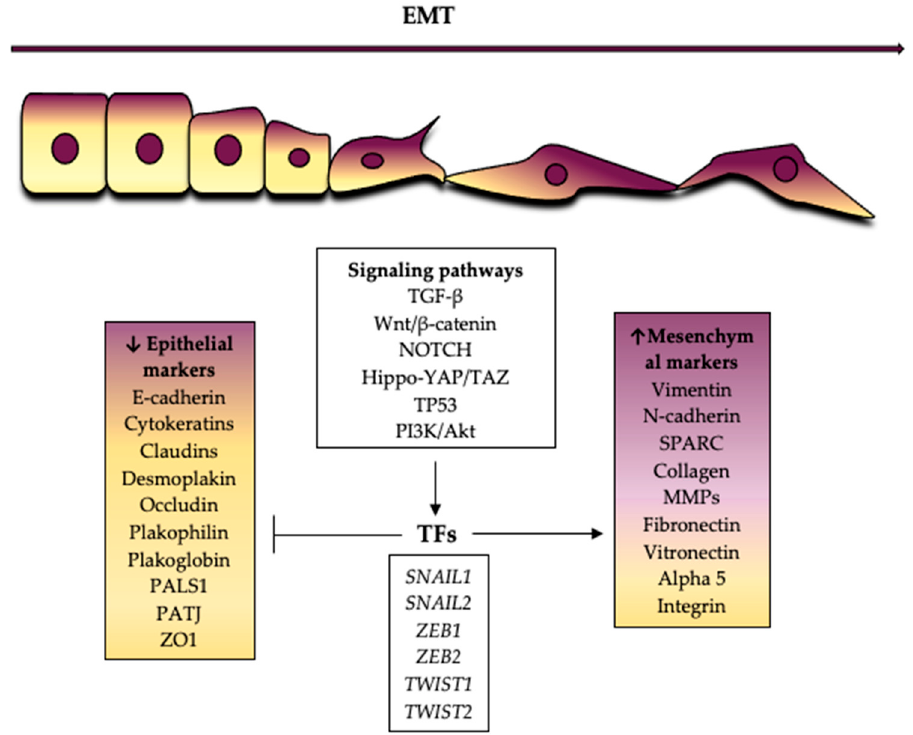
Figure 1. Epithelial and mesenchymal markers whose expression is decreased or increased during epithelial mesenchymal transition.